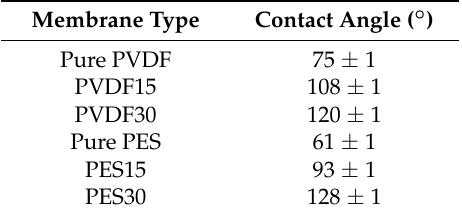
Table 2. Mean values of modified and unmodified membranes hydrophobicity.